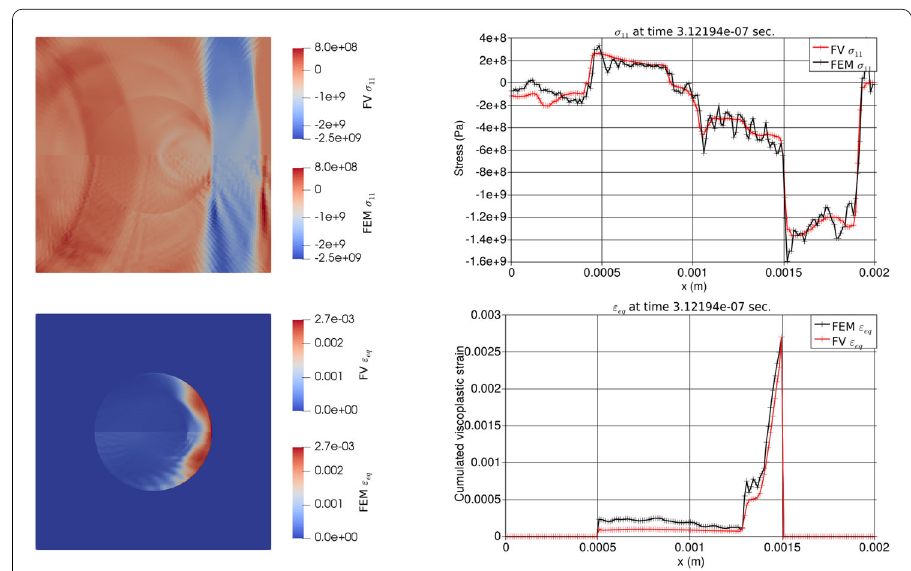
Fig. 20 Normal stress σ 11 and cumulated viscoplastic strains ε eq at time 3 . 12 × 10 − 7 s, computed with finite elements (bottom-half domain) and finite volumes (top-half domain). Superposed plots are made along the symmetry